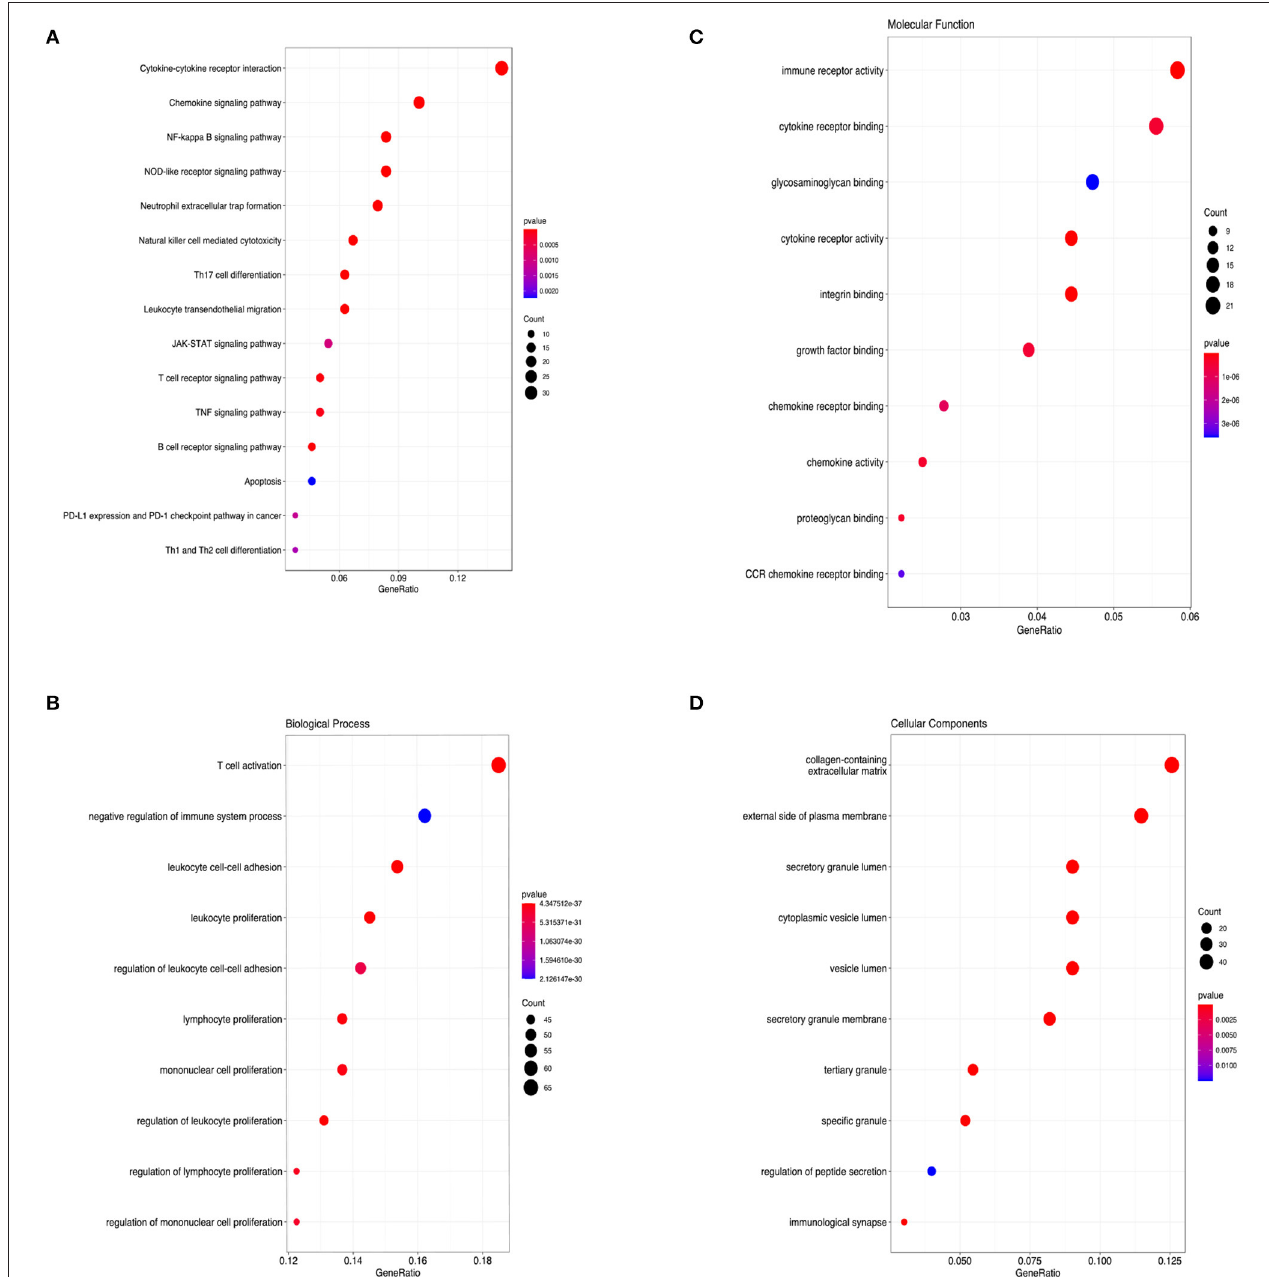
FIGURE 4 | (A) KEGG pathway enrichment analysis. (B) Biological process enrichment analysis. (C) Molecular function enrichment analysis. (D) Cellular component enrichment analysis.